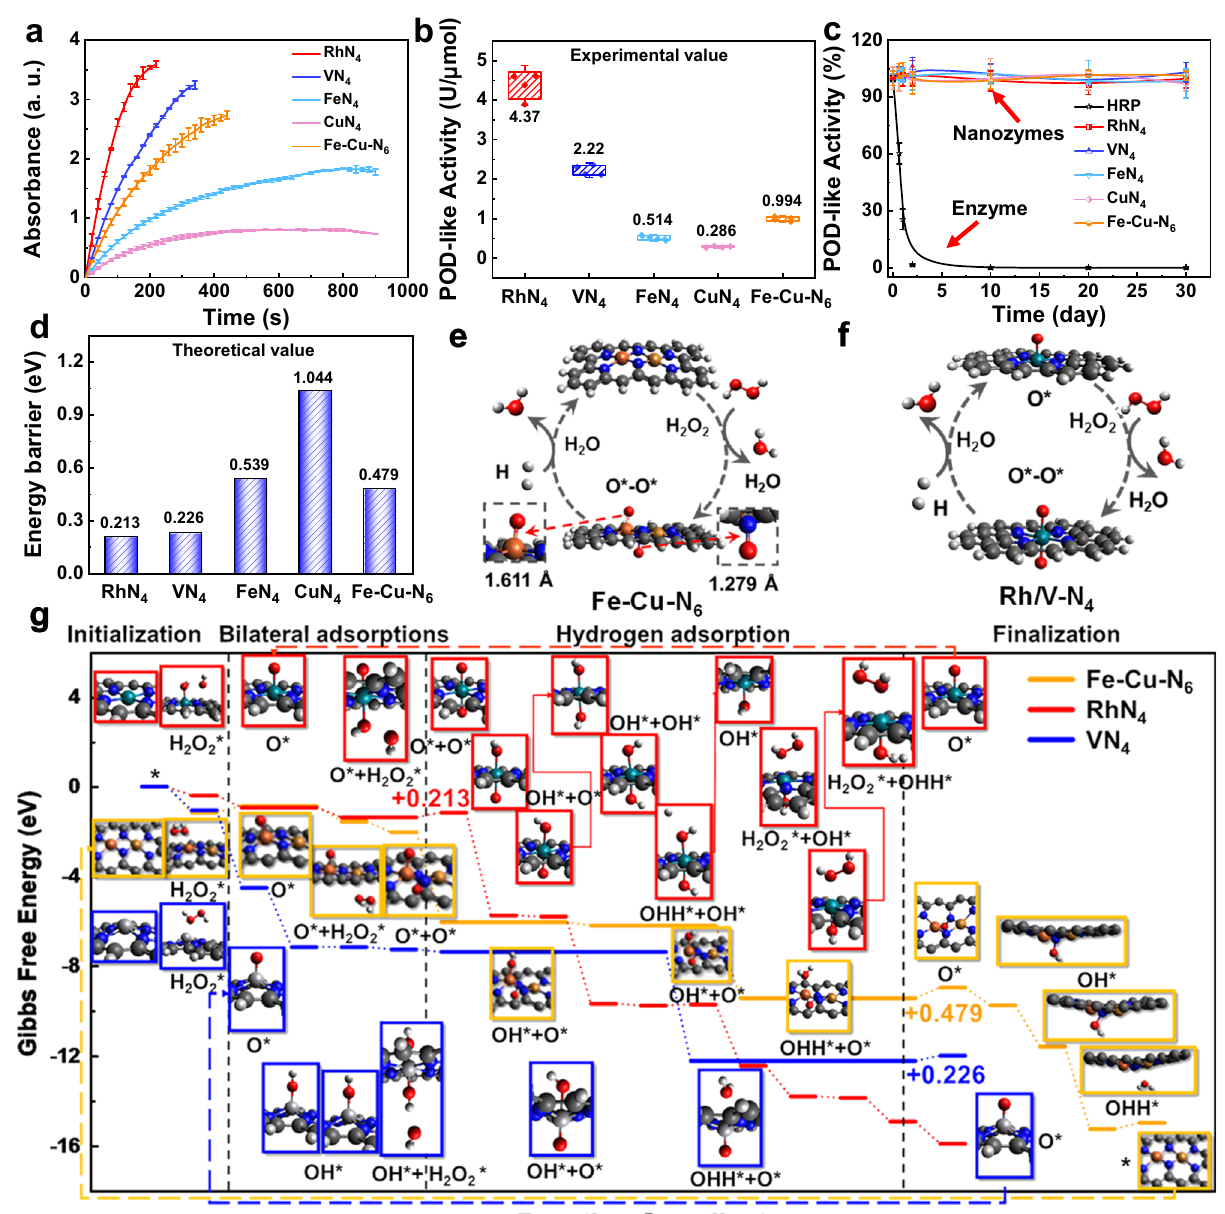
Fig. 3 | The POD-like activity of MN x . a Reaction-time curves of the TMB colori- metric reaction catalyzed by 1 μ M MN x , with the substrate concentration of TMB and H 2 O 2 at 800 μ M and 0.2M ( n =3 independent experiments). ‘ a. u. ’ represents arbitrary units. b Quanti fi cation of speci fi c POD-like activities of MN x ( n =4 inde- pendent experiments; boxes represent the median and interquartile range (IQR) andtheupperandlowerwhiskersextendingtothevaluesthatarewithin1.5×IQR). The speci fi c activity value (U/ μ mol) was determined by dividing the POD-like activity by the metal-based active sites. c Comparison of the stability of POD-like